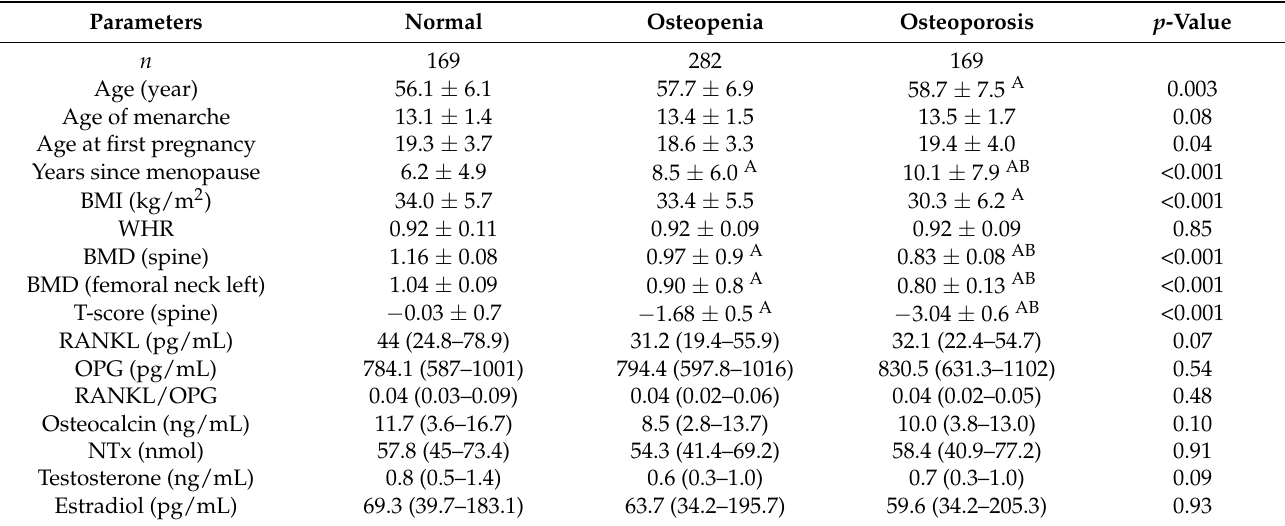
Table 1. Clinical characteristics of participants.